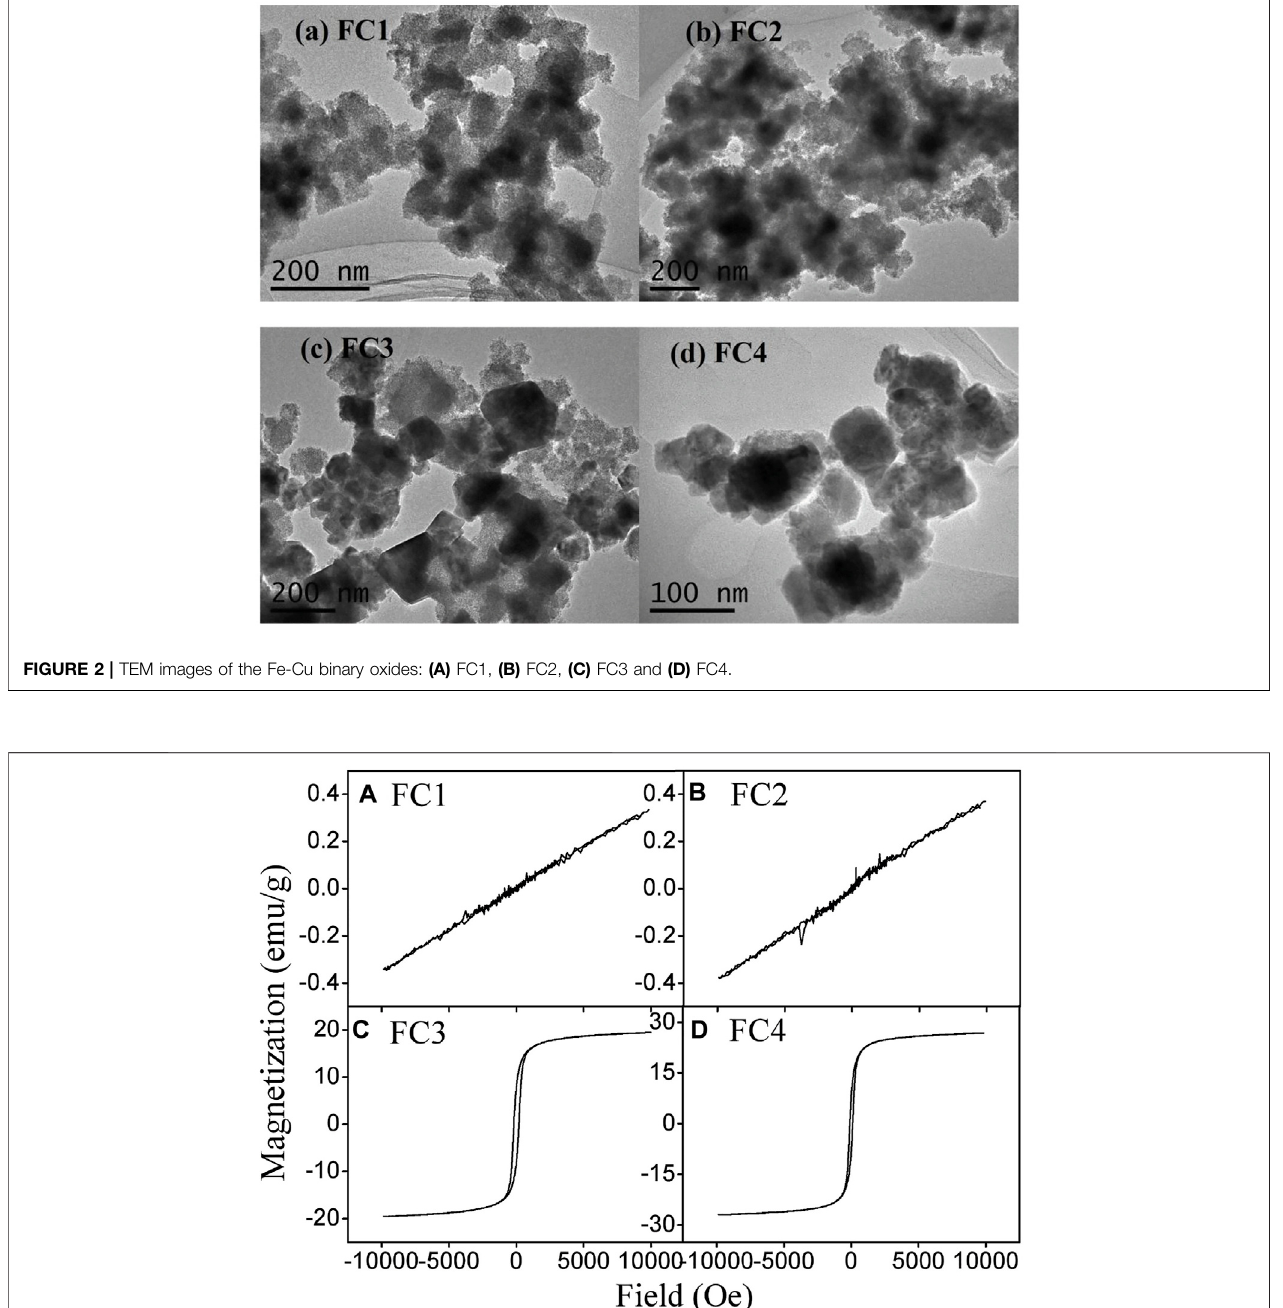
Frontiers in Chemistry |